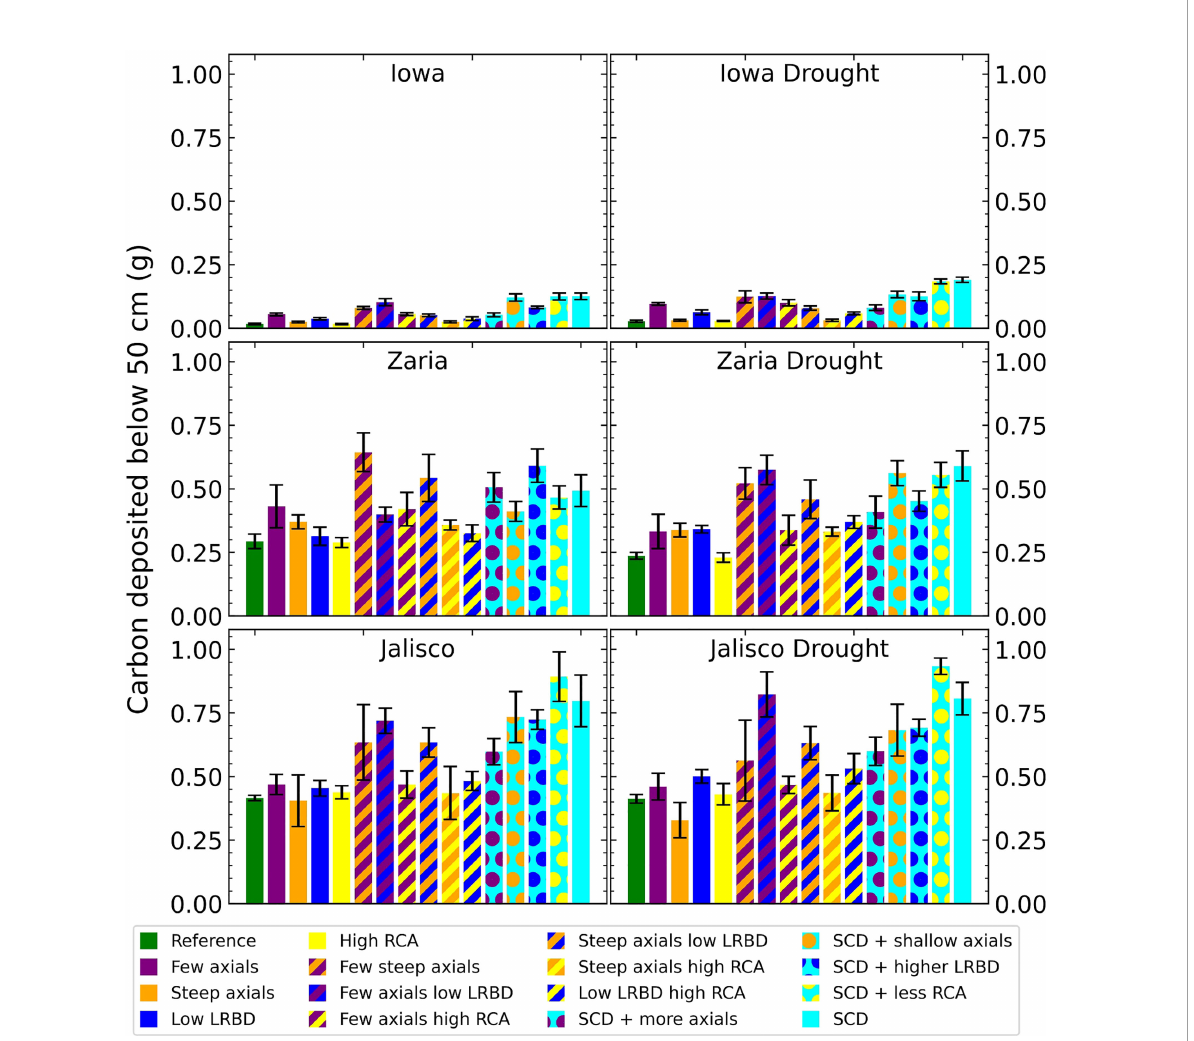
FIGURE 9 Carbon depositions below 50 cm deep in the soil of all the maize phenotypes considered after 42 days in the 6 different environments. The error bars indicate standard deviation, n (replicates) = 5. LRBD means lateral root branching density, RCA means root cortical aerenchyma and SCD refers to the steep, cheap, deep